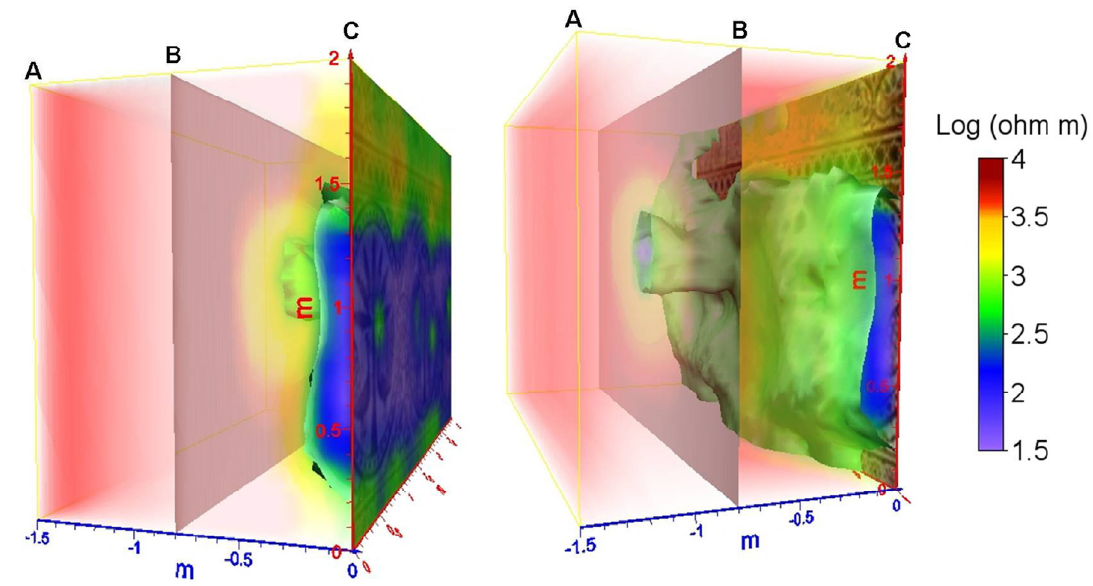
Figure 5. Electrical resistivity tomography (ERT) results in precious wall mosaics, fountain room of the Zisa Palace, Palermo, Italy. 3D representation of the inversion model, from a front point of view (left picture) and rear (right picture). Plane A —external wall surface. Plane B —investigation depth. Plane C —internal wall mosaic surface. Green and blue colors indicate the areas of low resistivity corresponding to the detected presence of moisture. After Fiandaca et al. [70] (reprinted with copyright permission).